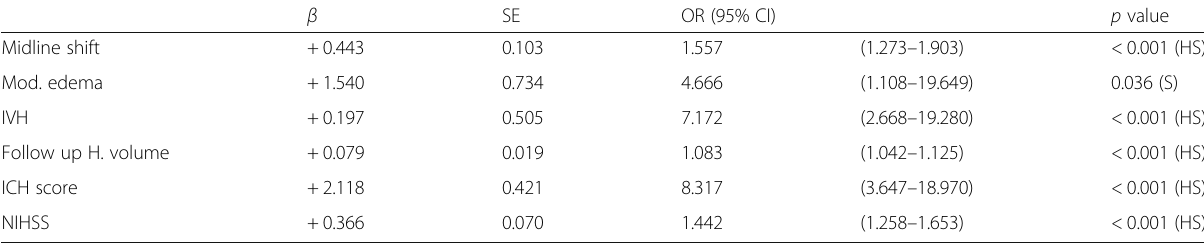
Table 2 Predictors for overall mortality in the studied cross section ( N = 120) by univariate analysis β